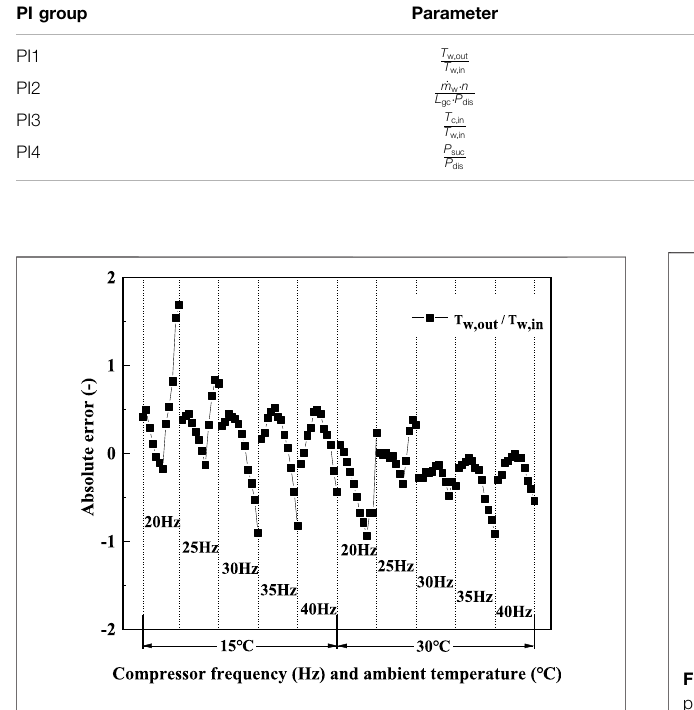
FIGURE 10 | Absolute error of PI1.